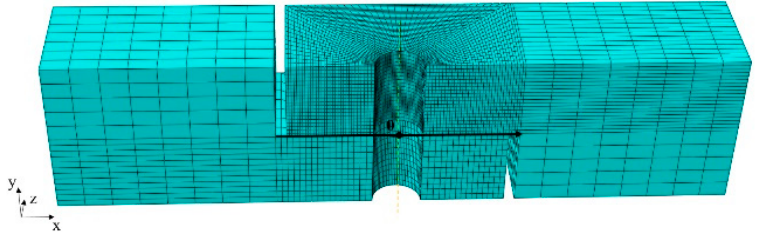
Figure 15. The finite element model of lapped plates.